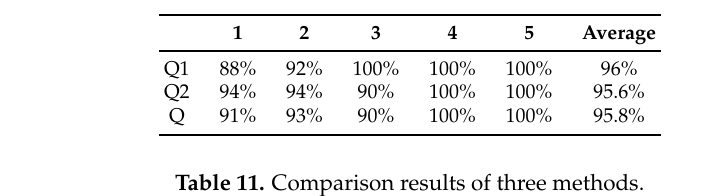
Figure 18. Output values of five test experiments. Table 10. Accuracy of five test experiments.